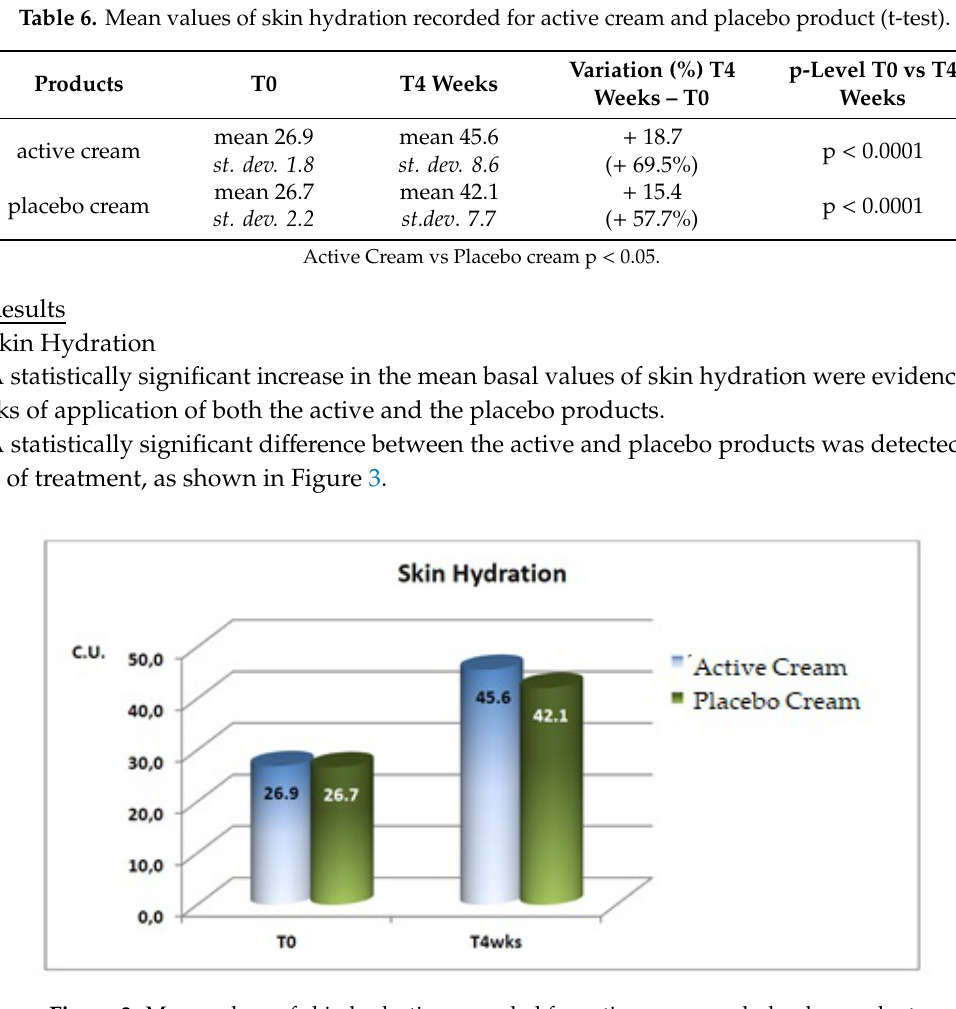
Figure 3. Mean values of skin hydration recorded for active cream and placebo product.